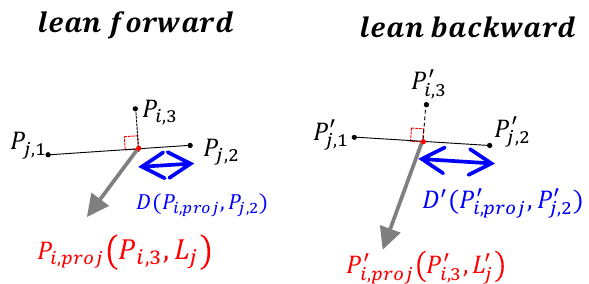
Figure 9. Dynamic shift for slippage